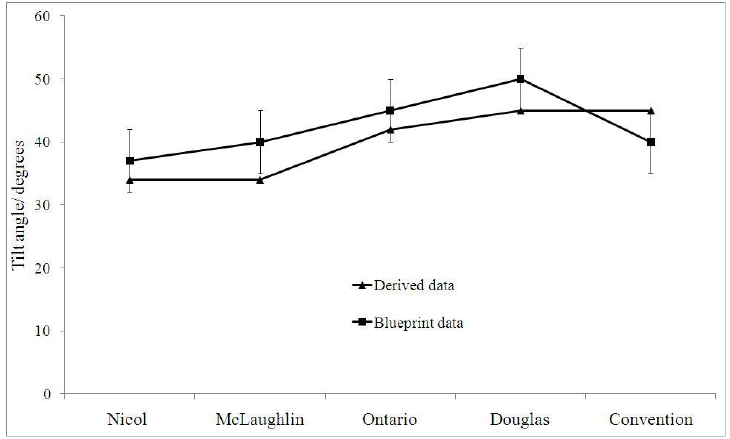
Figure 8. Error analysis of angles for reconstructed selected